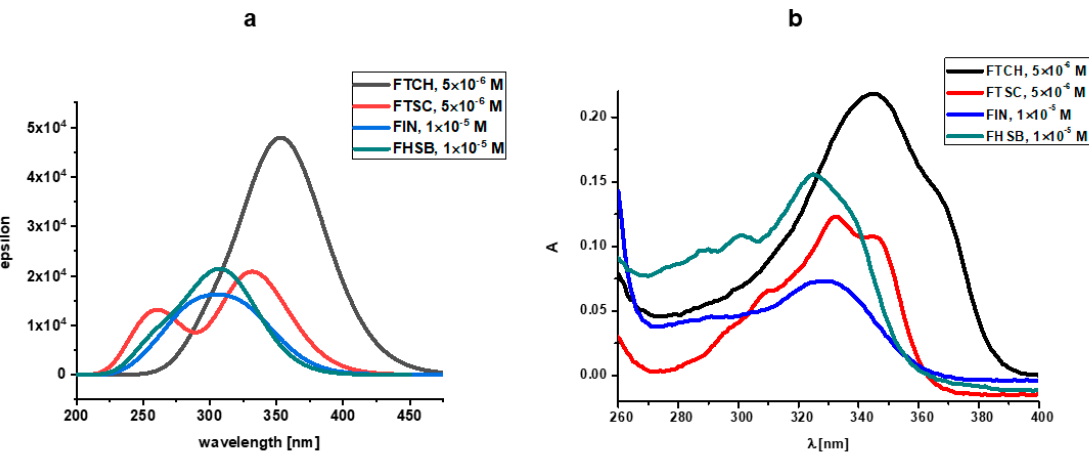
Figure 4. ( a ) The TD(DFT(B3LYP)/6-31+G(d,p)/PCM(DMSO) UV-Vis electronic spectra of the compounds studied ( b ) experimental UV-Vis spectra of the compounds studied in DMSO. Table 3. The TD (nstates = 10) DFT(B3LYP)/6-31+G(d,p)/PCM calculated spectroscopic parameters (transition electric dipole moment ( µ ); wavelength corresponding to the excitation energy ( λ ) and oscillator strength (f)) of the electronic transitions to the three low-lying excited singlet states of S enantiomers of FHSB, FIN, FTSC, and FTCH. Compound